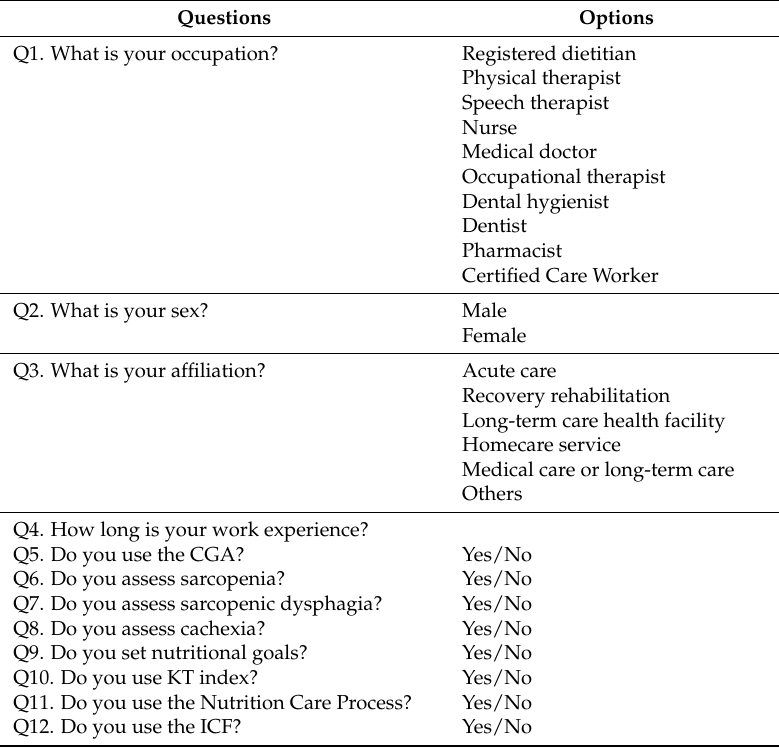
Table A1. Questionnaire contents.